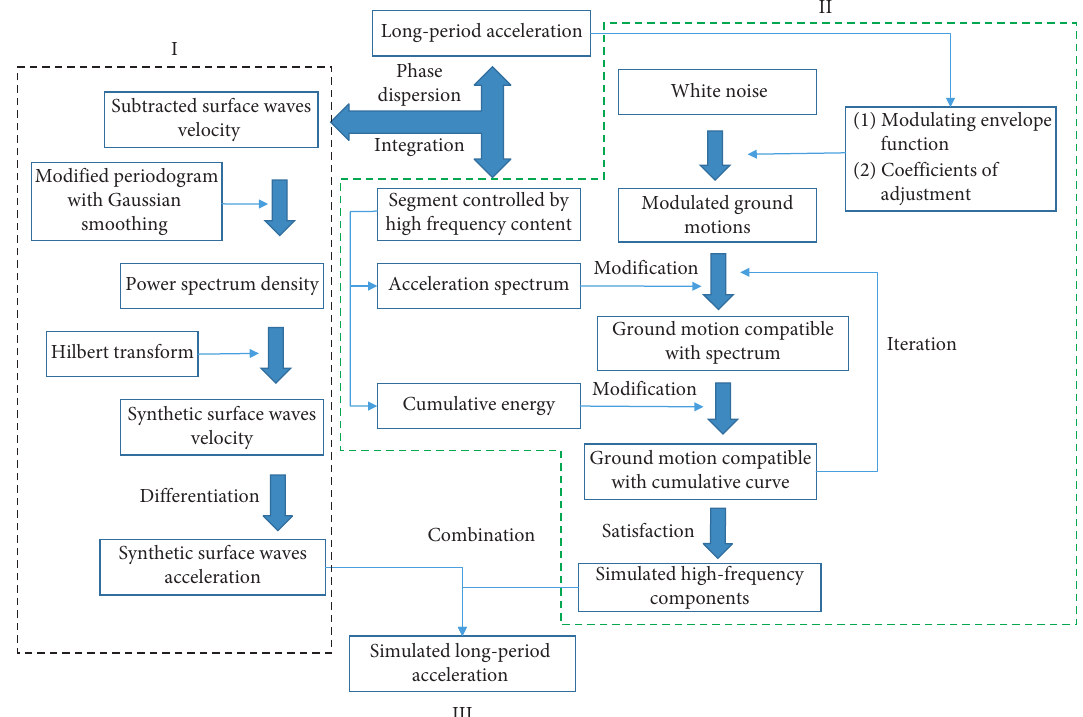
Figure 23: Schematic plot for generating long-period ground